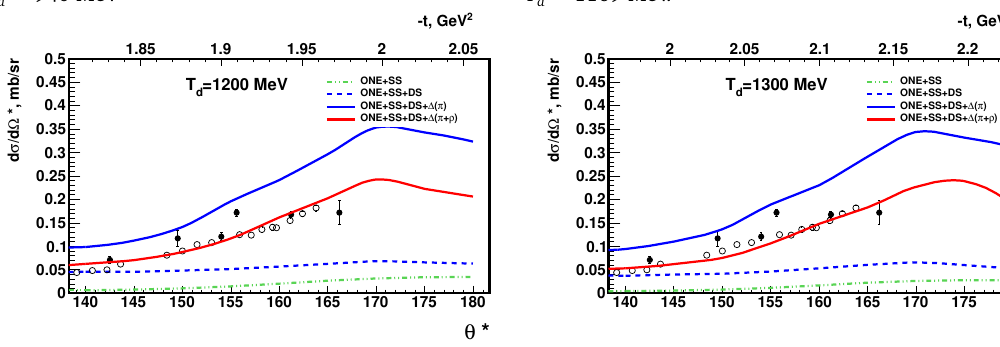
= 1300 MeV. d = 1169 MeV, • - [ 25 ] d